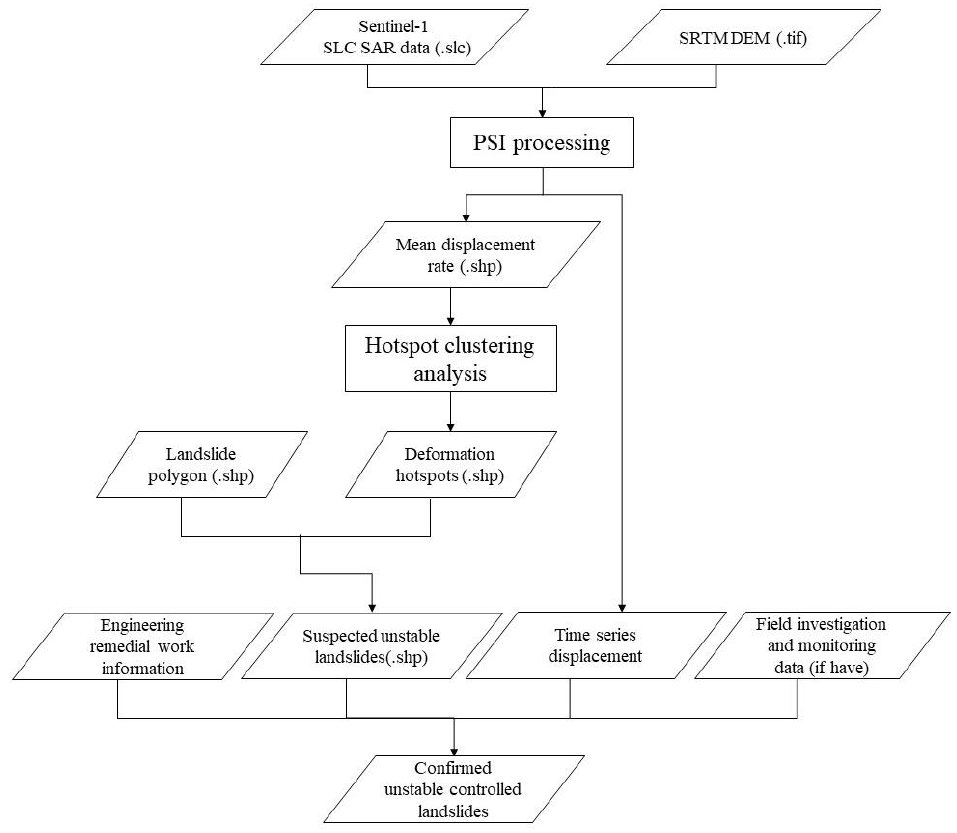
Figure 3. Flow chart illustrating the adopted methodology.